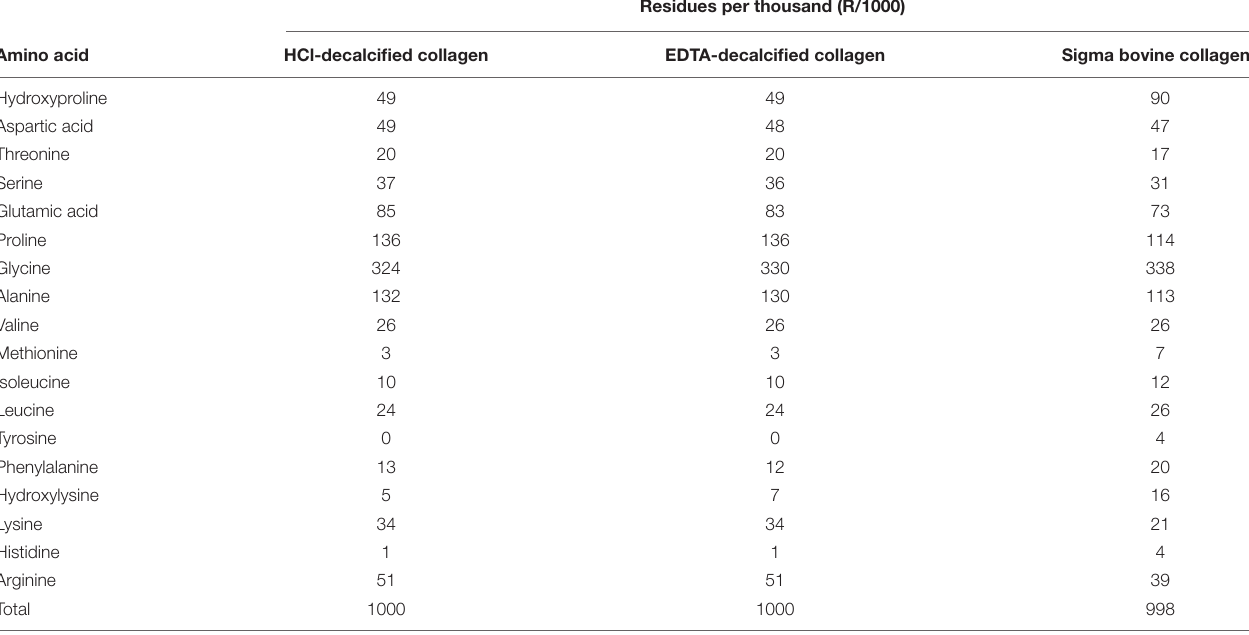
TABLE 2 | Quantitative amino acid analyses on Hartley adult mammoth bone